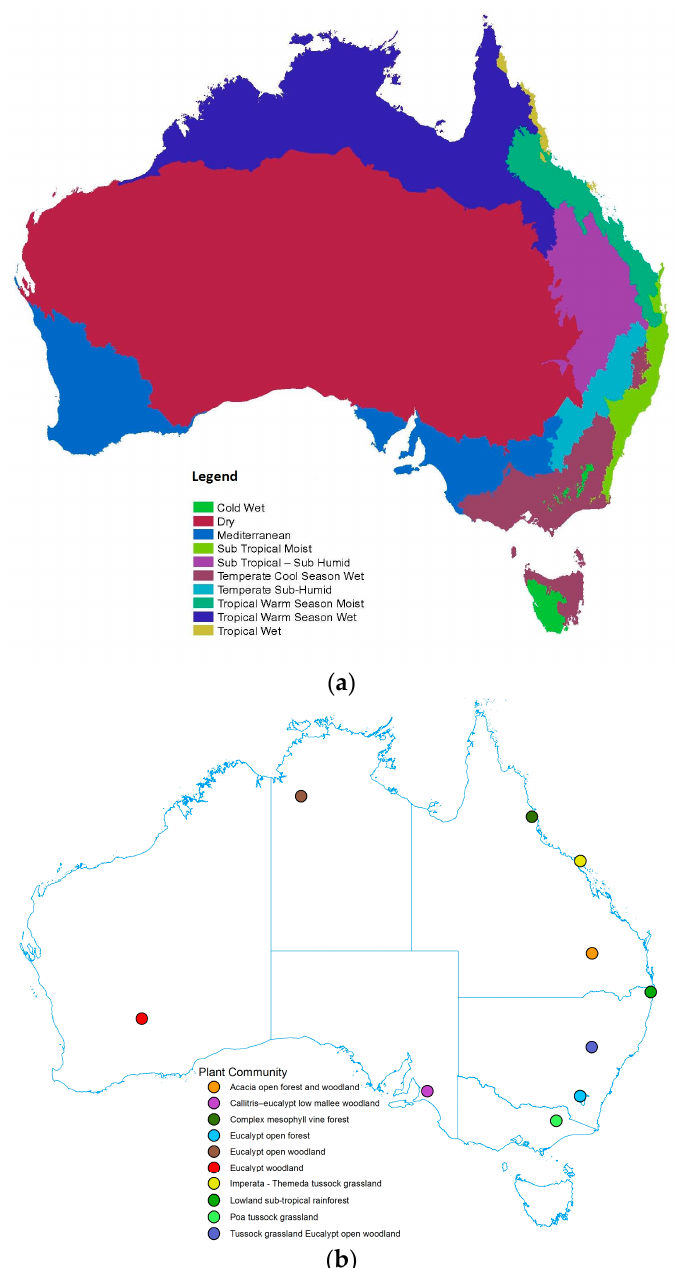
Figure 1. ( a ) Extent of the 10 agro-climatic regions; and ( b ) location of the 10 sites and the associated plant community type (refer to Tables S1 and S2 in the Supplementary Material).